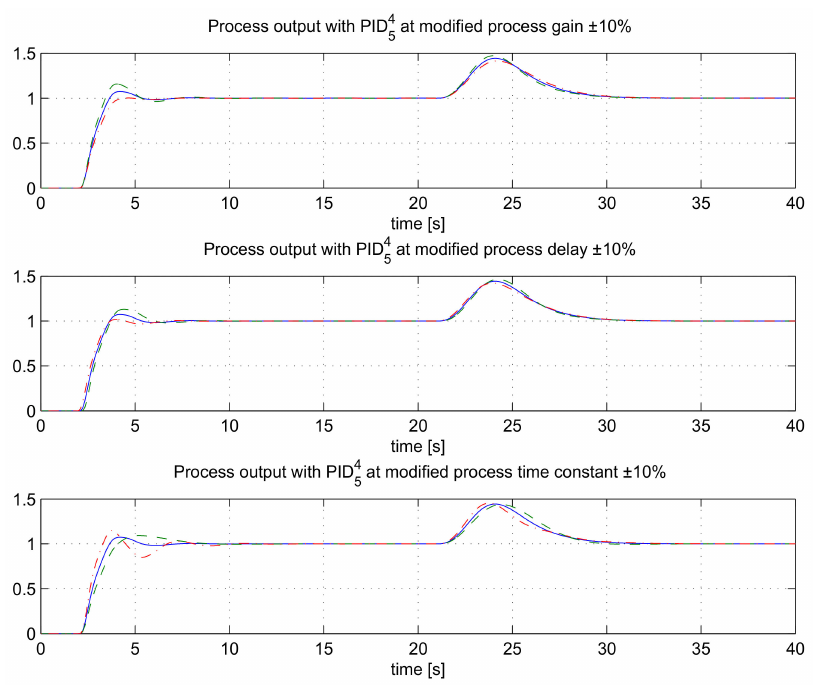
Figure 12. The closed-loop responses for the process G P 4 ( s ), using controller PID 4 for nominal (solid line), 10% increased (dashed line) and 10% decreased (dash-dotted line) process